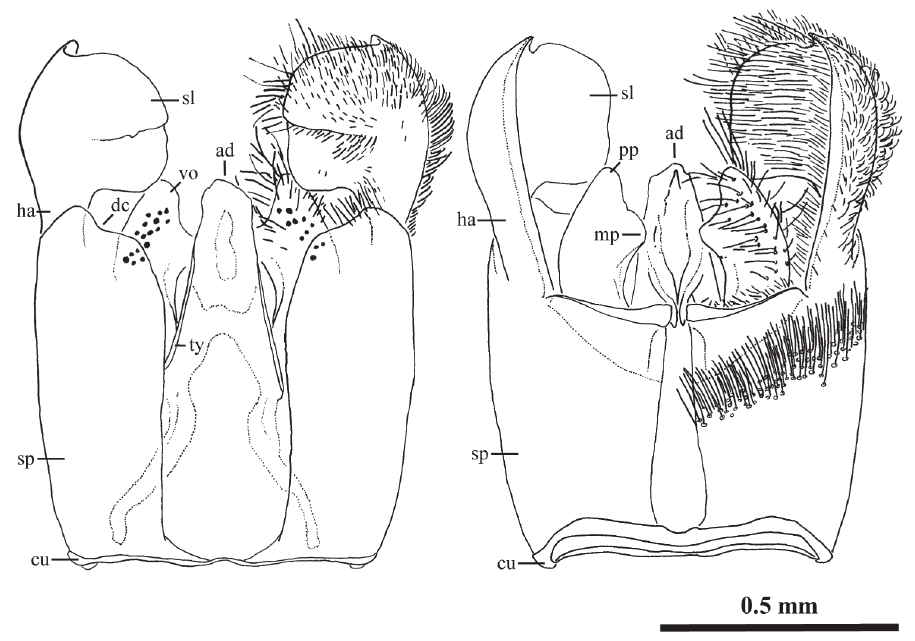
Figure 26. Male genital of C. andreasmuelleri (dbM No. 3454) in dorsal (left) and ventral view (right). (Setae only shown on one side of each drawing; Nomenclature follows that of Birket-Smith (1981): ad, aedoeagus; cu, cupula; dc, dorso-medial concavity of the posterior margin of the stipes; ha, harpide; mp, medial process of volsella; pp, posterior process of volsella; sl, shovel-like dorso-medial lobe of harpide; sp, stipes; ty, thyrsos; vo,